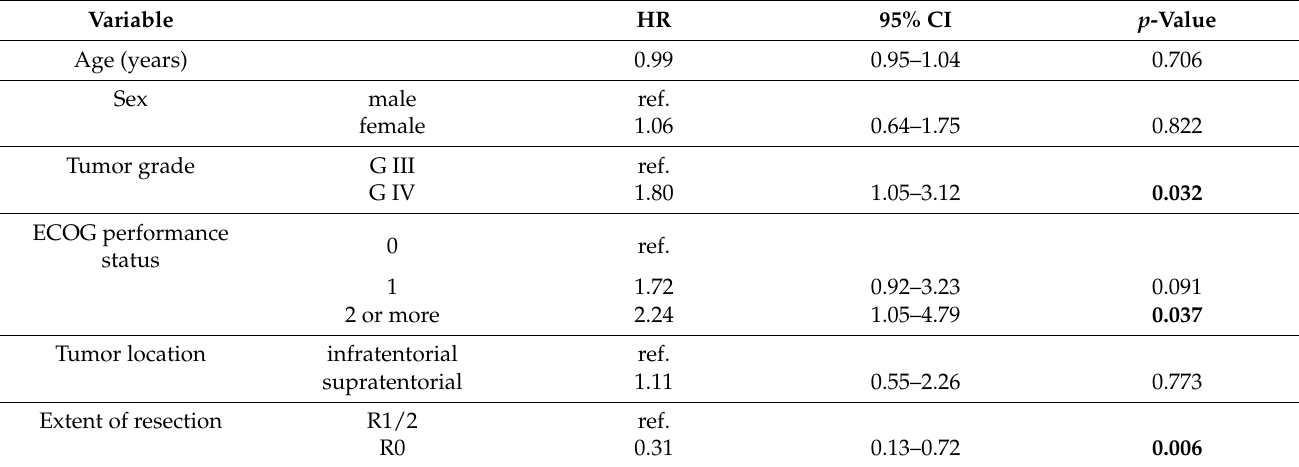
Table 3. Prognostic factors: univariate analysis of progression-free survival for the whole